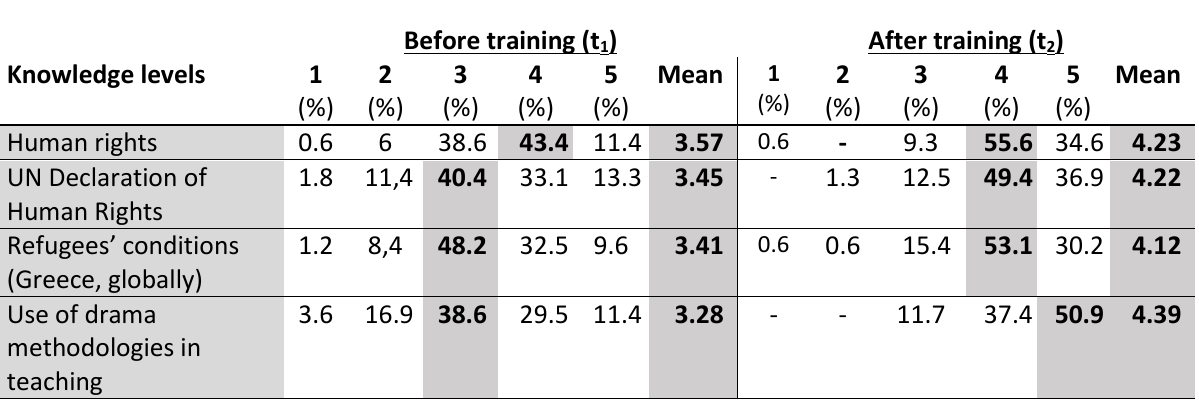
The ‘sense of knowledge’ scale (percentages and means)